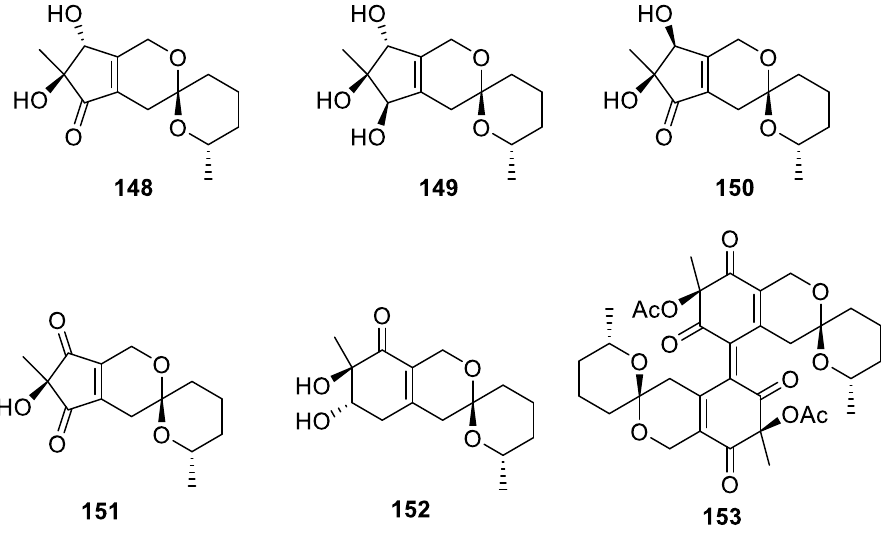
Figure 70. Thielavialides A − E ( 148 – 152 ) and pestafolide A ( 153 ).